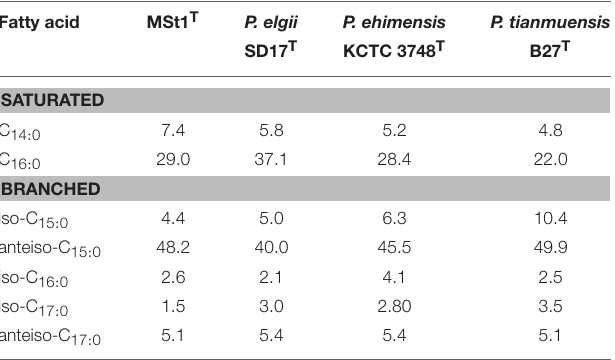
TABLE 2 | Cellular fatty acid profile of strain MSt1 T when compared to its closely related type species of Paenibacillus. Fatty acid MSt1 T